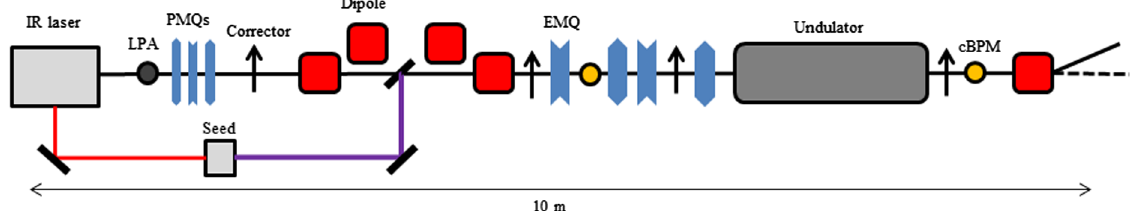
FIG. 1. COXINEL schematic view. LPA: laser plasma accelerator, PMQ: Permanent magnet quadrupole, EMQ: electromagnetic quadrupole, cBPM: cavity beam position monitor [44,45] for orbit correction, Seed: coherent source at 200 nm generated by frequency mixing using the same IR laser as for electron beam generation. Undulator: center located at 6.796 m from the LPA source